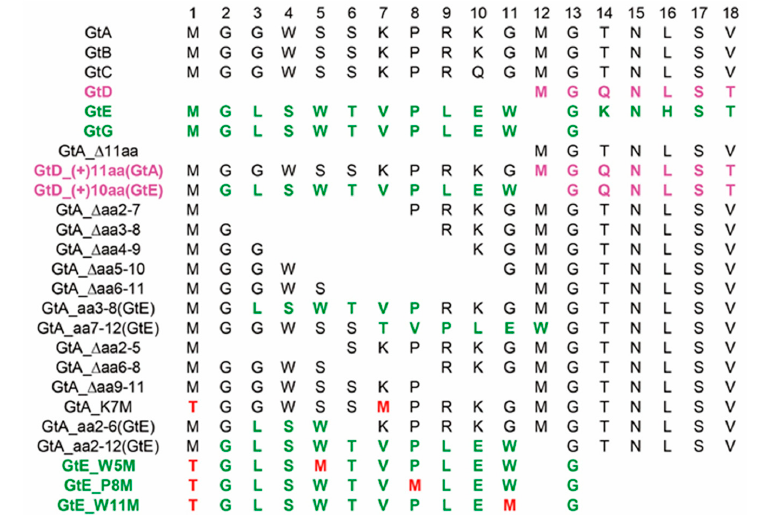
Figure 1. Sequence comparison of amino acids 1 – 18 in the pres1 of different genotypes and the derivatives.